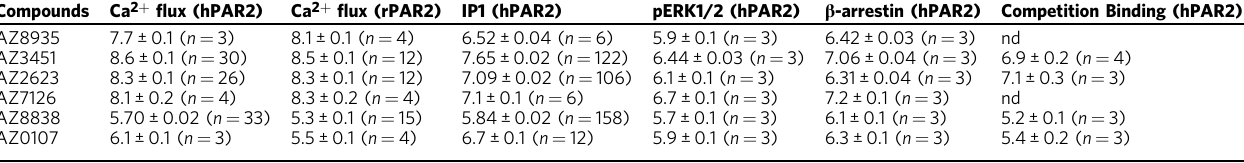
Table 1 In vitro pharmacology of PAR2